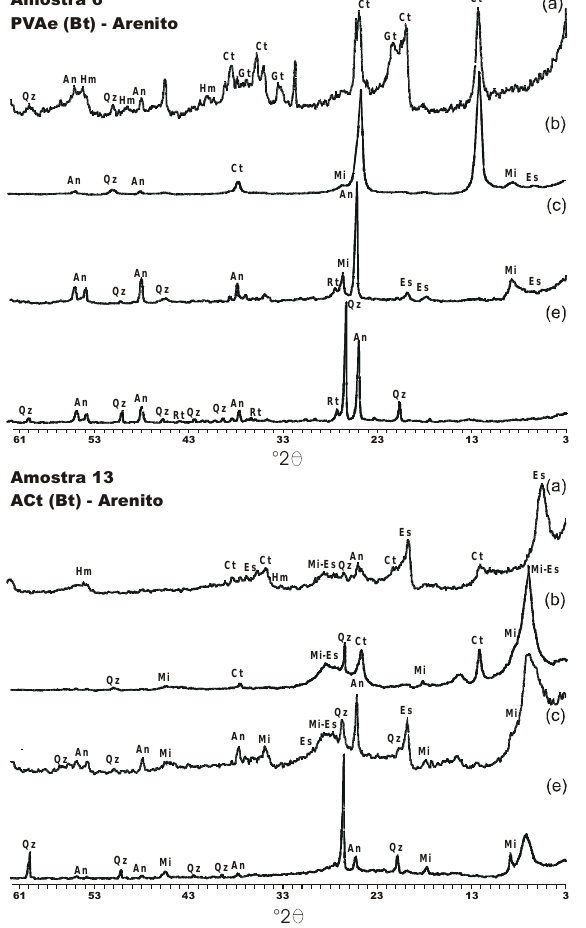
Figura 2. Difratogramas de raios-X da fração argila Figura 1. Difratogramas de raios-X da fração argila orientada do LVwf e do NVef da Formação orientada do PVAe da Formação Adamantina Serra Geral, mostrando a mineralogia com os e do ACt da Formação Uberaba, mostrando a tratamentos seqüenciais (sem tratamento (a), mineralogia com os tratamentos seqüenciais após DCB (b), após NaOH 5 mol L -1 (c), após (sem tratamento (a), após DCB (b), após NaOH NaHSO e NaOH 0,5 mol L -1 (e)): An - anatásio, 5 mol L -1 (c), após NaHSO e NaOH 0,5 mol L -1 4 4 Ct - caulinita, Es - esmectita, Fd - feldspato (e)): An - anatásio, Ct - caulinita, Es - esmectita, potássico, Gb - gibbsita, Gt - goethita, Hm - Gt - goethita, Hm - hematita, Mi - mica, Mi-Es - hematita, Mgm - maghemita, Mi - mica, Qz - interestratificado mica-esmectita e Qz - quartzo e Rt - rutilo.